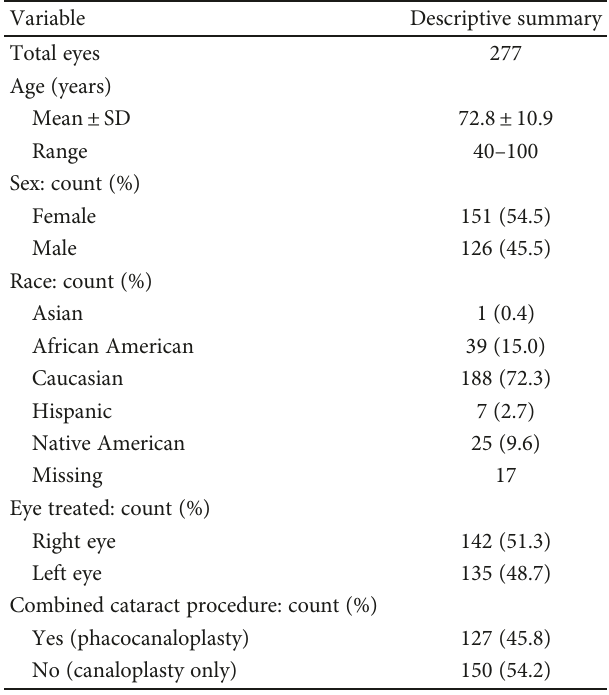
Table 1: Study group demographics of all